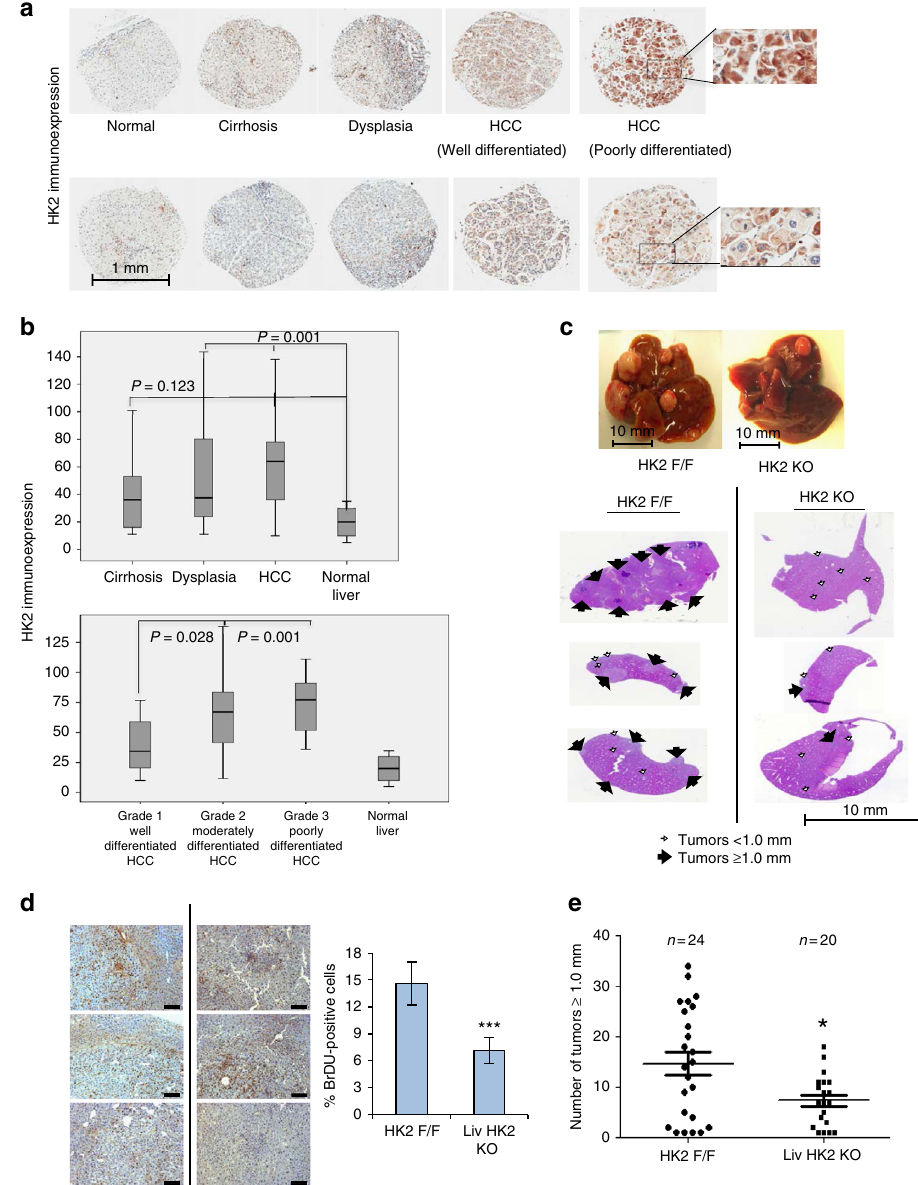
Fig. 1 HK2 in the development of HCC. a Immunocytochemistry (IHC) for HK2 in human patient samples at various stages of liver disease (inserts show x3 magn fi cation). b Upper panel- quanti fi cation of HK2 expression in cirrhosis dysplasia and HCC. Signi fi cant differences for HCC ( p < 0.001) and dysplasia ( p = 0.001) vs. controls. No signi fi cant difference between cirrhosis and controls ( p = 0.123 by Friedman test, cirrhosis ( n = 106), dysplasia ( n = 143), HCC ( n = 45), and normal ( n = 6)). Lower panel — quanti fi cation of HK2 expression within different grades of HCC. Poorly differentiated vs. well differentiated, p = 0.001. Moderately differentiated vs. well differentiated, p = 0.028 by ANOVA. Quanti fi cation is based on HK2 expression analysis of 312 samples from 151 patients exhibiting liver disease with different etiologies. For both panels box plot center line represents mean, box limits represent 25% and 75% con fi dence limits, and whiskers extend to the minimum and maximum values. c Two-week-old HK2 F/F and HK2 F/F ;AlbCre male mice were injected with DEN (25 mg/kg). Nine months after DEN injection, mice were analyzed. Upper panel — representative liver images. Bottom panel — representative H&E stained tumor section (arrows indicate tumors). d Images of liver sections showing BrdU incorporation (left panel), and quanti fi cation (right panel). Scale bars: 100 µ m (20× objective). Results are presented as the mean ± SEM percentage of positively stained cells from four section fi elds. *** p < 0.001 versus HK2 F/F /, by Student ’ s t -test. e Quanti fi cation of tumor incidence as measured by the number of tumors greater than or equal to 1.0 mm. The number of mice in each group is indicated. * p < 0.05 versus HK2 F/F , by Student ’ s t